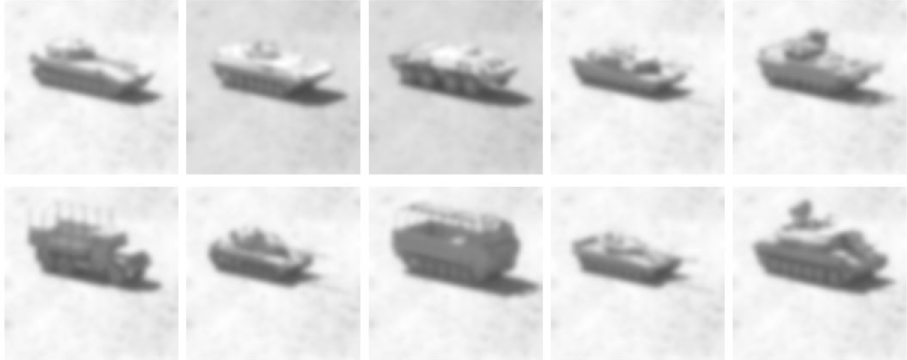
Figure 3. Examples of EO data from each class (class order remains the same). Reproduced with permission from [17]. 2022, SPIE.